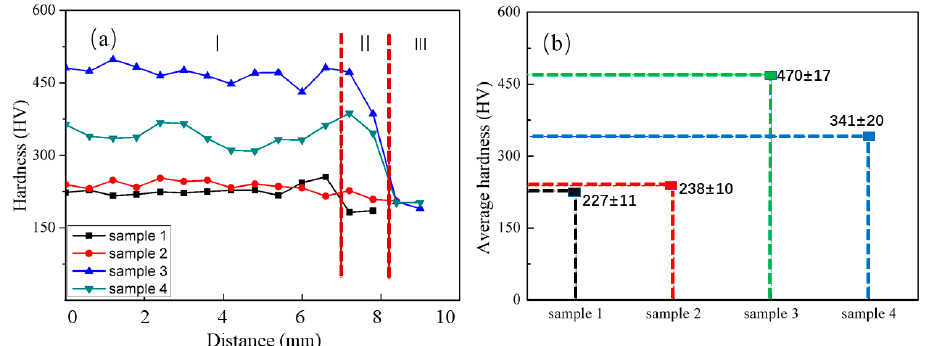
Figure 5. The curves of hardness ( a ) and average hardness ( b ) of samples (I is the arc additive manufactured layers, II is the heat-affected zone, and III is the substrate).